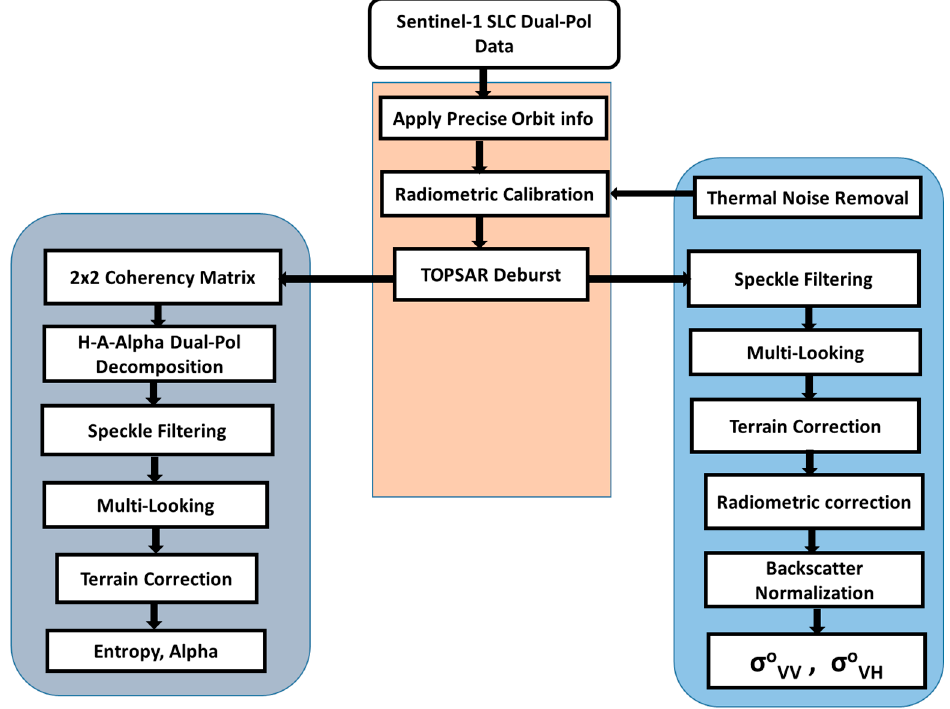
Figure 8. Flowchart of Sentinel-1 single look complex data pre-processing steps.